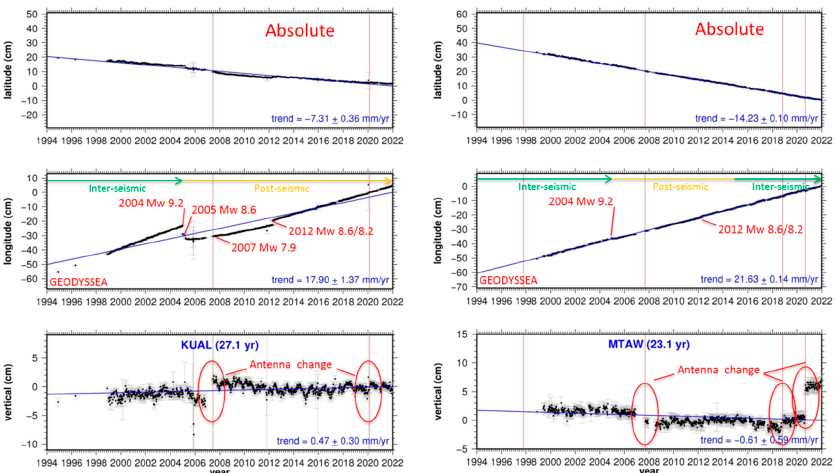
Figure 8. Unfiltered absolute 3D GPS position time series (1994–2021) for stations KUAL (Kuala Terengganu, Peninsular Malaysia) and MTAW (Tawau, Sabah, East Malaysia), with the 1994–1998 positions coming from the GEODYSSEA campaign measurements. In the longitude position figures, the major earthquake events that resulted in horizontal co-seismic position offsets are shown (2004 Mw 9.2 Sumatra–Andaman, 2005 Mw 8.6 Nias, 2007 Mw 7.9 Bengkulu, and 2012 Mw 8.6/8.2 Indian Ocean). Shown also (approximately) are the inter- (green) and post-seismic (yellow) phases of the 2004 Mw 9.2 Sumatra–Andaman earthquake. Antenna changes that have impacted the vertical position time series are also shown by red ellipses. Finally, the (raw) linear trend estimates are shown in blue.